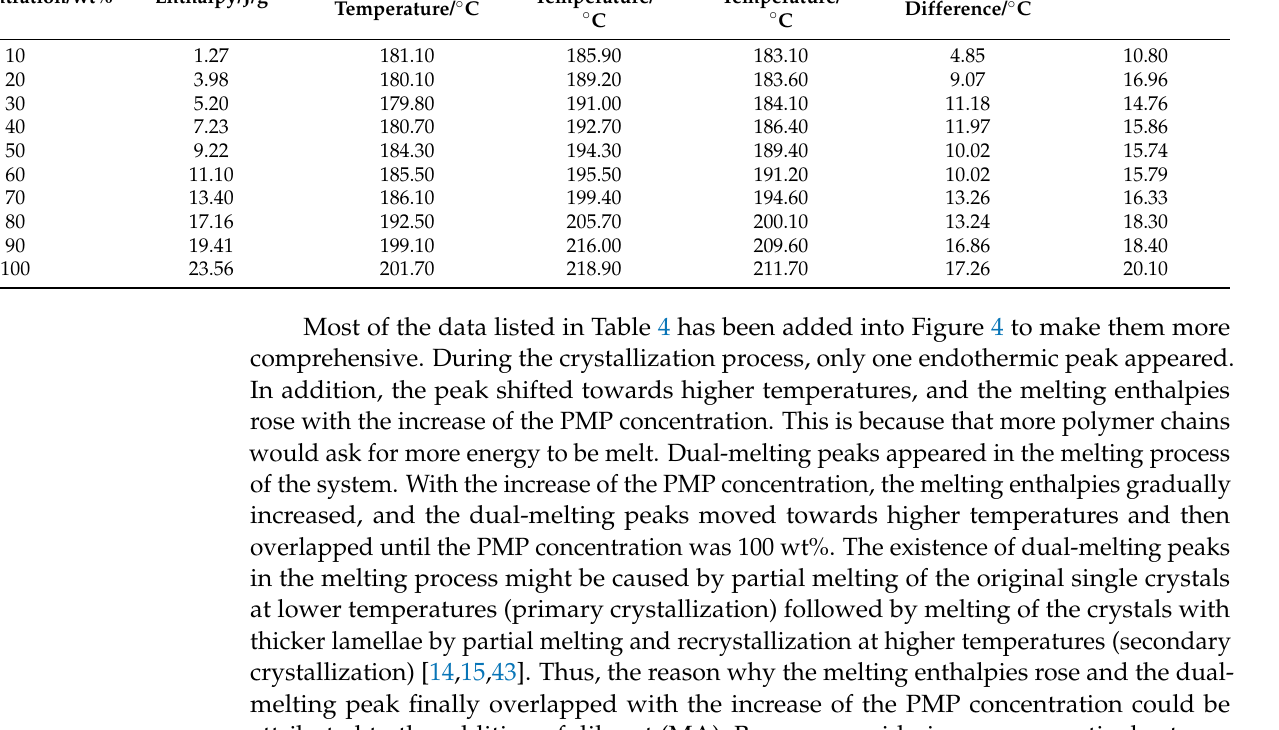
Table 4. The melting enthalpy and crystallinity of the PMP-MA system with different PMP concentrations.